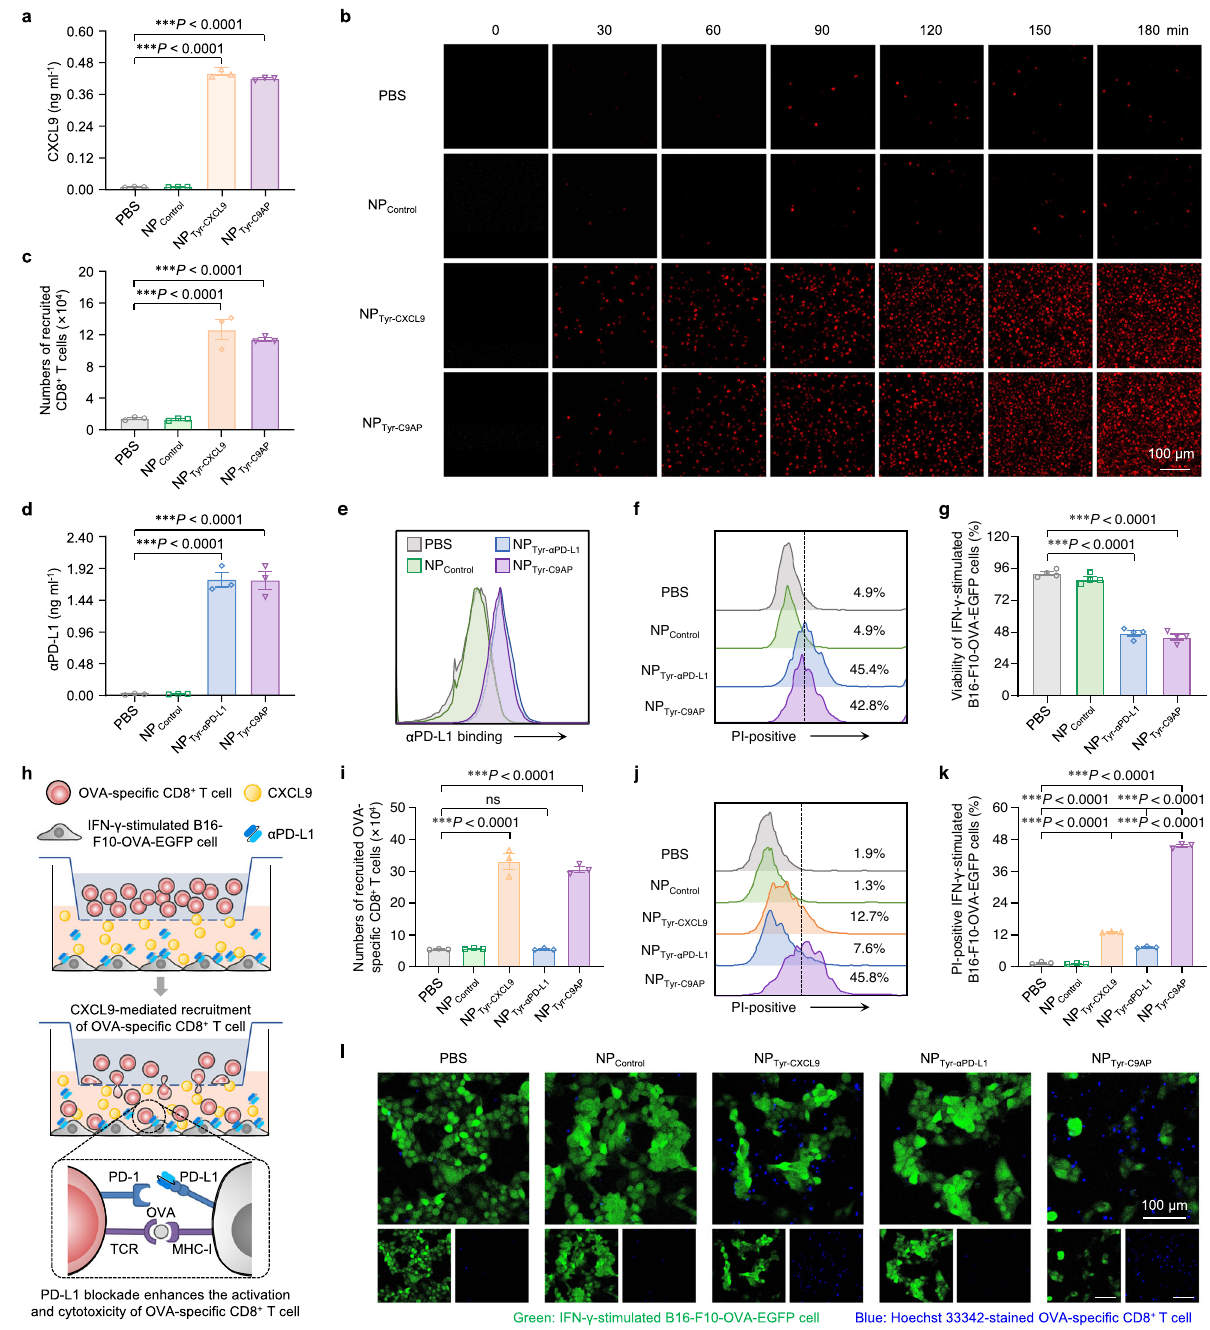
Fig. 3|NP Tyr-C9AP -mediatedcoexpressionofCXCL9 and α PD-L1enhancesT-cell recruitment and activation in vitro. a Concentrations of CXCL9 secreted in the culture supernatants of B16-F10 cells after the transfection of NP Tyr-C9AP or other controls. b , c CLSMimaging( b )and fl owcytometry-basedcellcounting( c )ofCD8 + T cells (stained with DiIdye, red) recruited intothe lower chamberof the transwell plates after addition of the culture supernatants of the B16-F10 cells transfected with NP Tyr-C9AP or other controls. d Concentrations of α PD-L1 secreted in the cul- turesupernatantsoftheB16-F10cellstransfectedwithNP Tyr-C9AP orothercontrols. e Flow cytometry analysis of the PD-L1 binding capacity of α PD-L1 secreted by the NP Tyr-C9AP -transfected B16-F10 cells. f , g Flow cytometry analysis of PI-positive (dead) percentages ( f ) and CCK-8 assays of cellviability ( g ) ofthe IFN- γ -stimulated B16-F10-OVA-EGFP cells after coincubation with OVA-speci fi c CD8 + T cells in the culture supernatants of the B16-F10 cells transfected with NP Tyr-C9AP or other